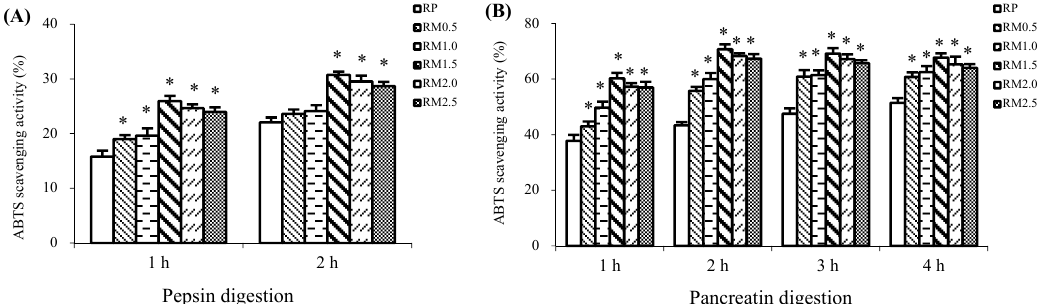
Figure 1. ABTS radical scavenging activities of rice protein (RP) and methionine added to rice protein (RM) hydrolysates during in vitro digestion with pepsin ( A ) and pancreatin ( B ). ABTS, 2,2 ′ -azinobis (3-ethylbenzothiazoline-6-sulfonic acid) diammonium salt. RM, methionine added to rice protein, in which methionine was added to 0.5, 1.0, 1.5, 2.0, and 2.5-fold of rice protein, respectively. RP, rice protein. Values are the means ± SEM ( n = 3). * p < 0.05, in comparison with RP.